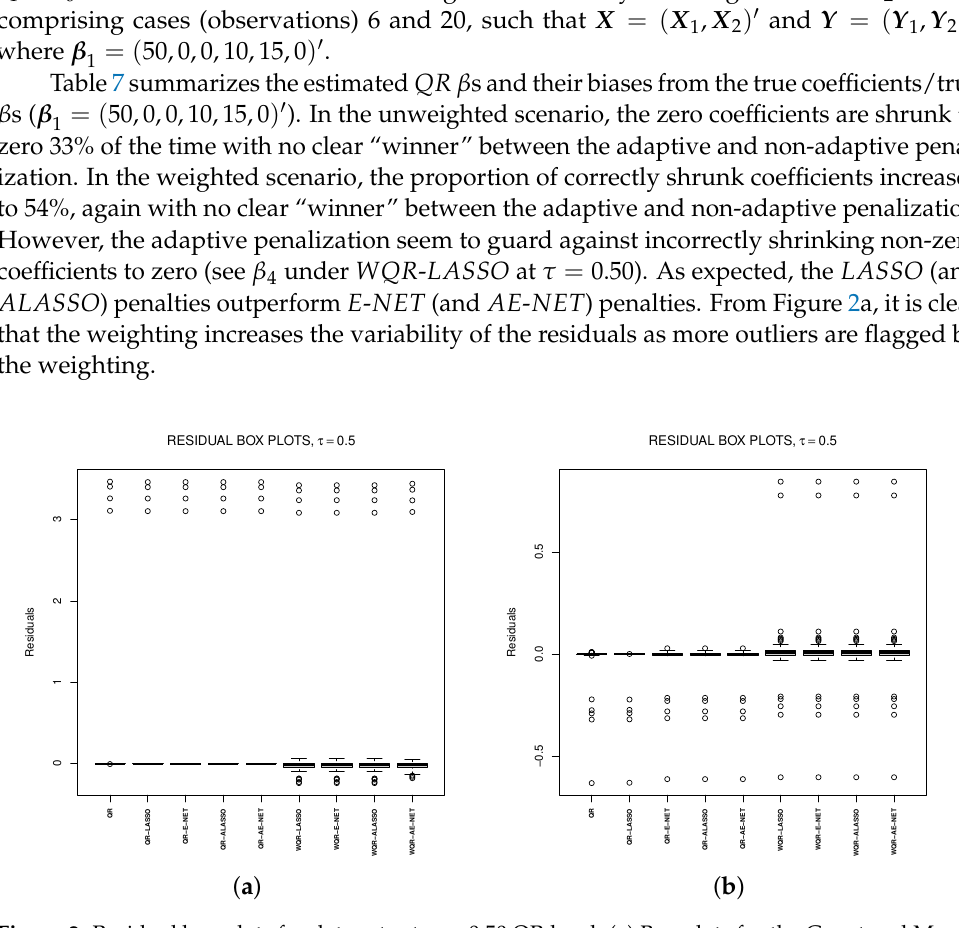
Figure 2. Residual box plots for data sets at τ = 0.50 QR level. ( a ) Box plots for the Gunst and Mason data set and ( b ) box plots for the Jet-Turbine Engine data